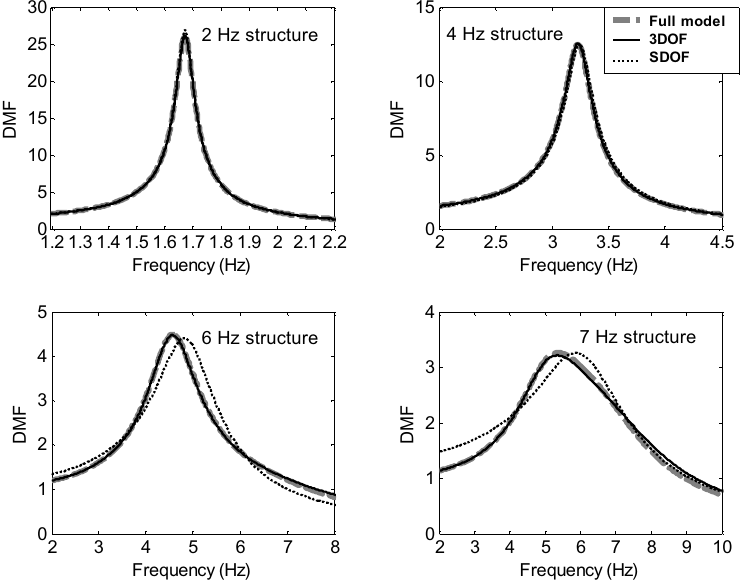
Fig. 10. DMF-frequency response curves for 2, 4, 6 adnd 7 Hz structures with mass ratio of 0.4. Each plot shows the responses of full model, equivalent SDOF and 3DOF models. The natural frequency refers to that of the structure when it is